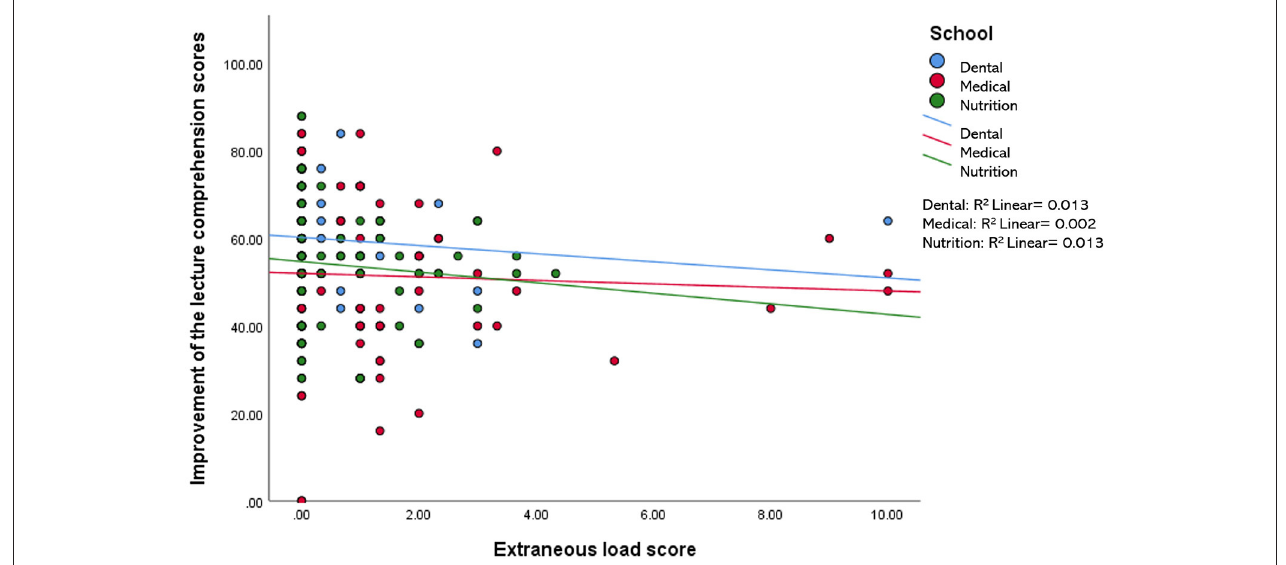
FIGURE 3 | Improvement of the lecture comprehension scores vs. the extraneous load score after the CLT-based online lecture.